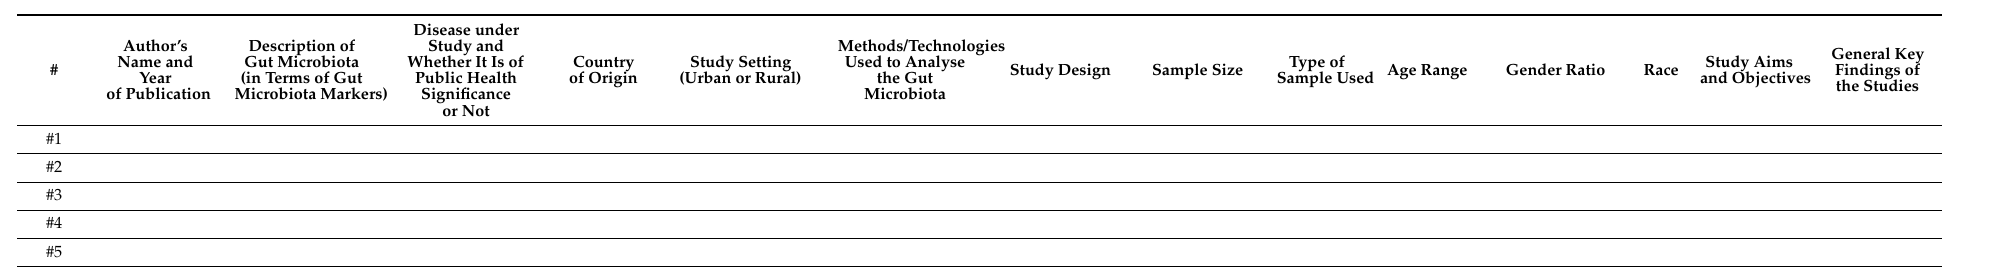
Table A2. Charting